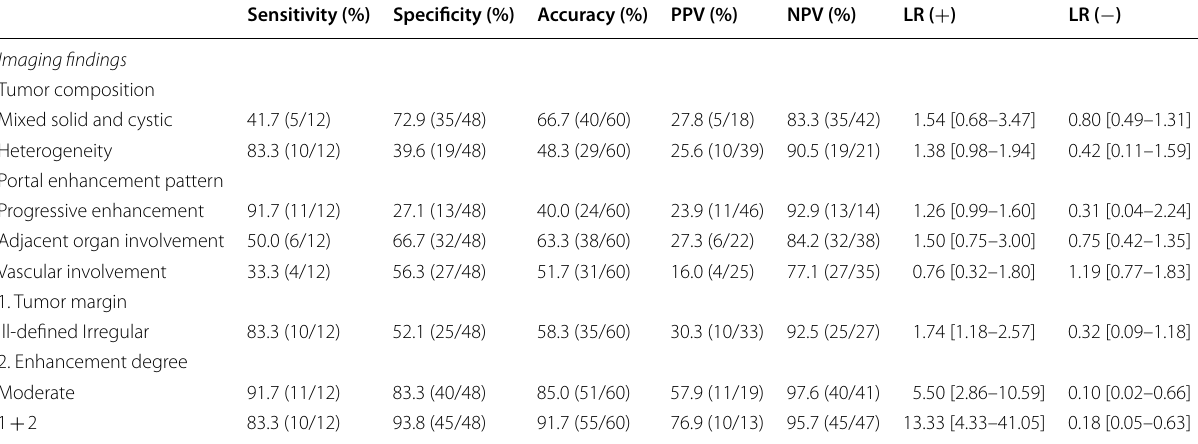
Data are number of patients, unless otherwise indicated; data in parentheses are numerator/denominator of patients; data in square brackets are 95% CIs MiNEN , mixed neuroendocrine–non-neuroendocrine neoplasm; PPV , positive predictive value; NPV , negative predictive value; LR ( negative likelihood